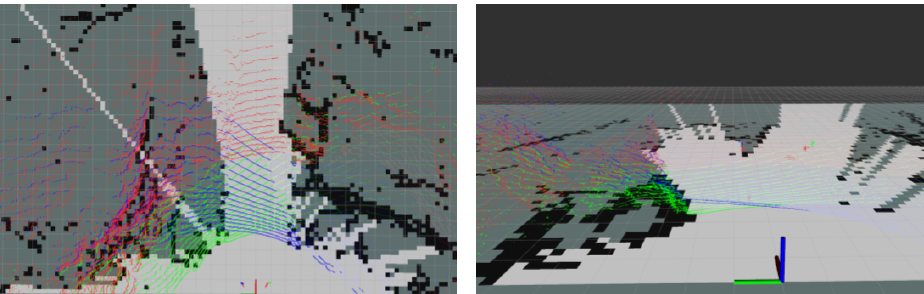
Figure 13. Local Occupancy Grid Map.